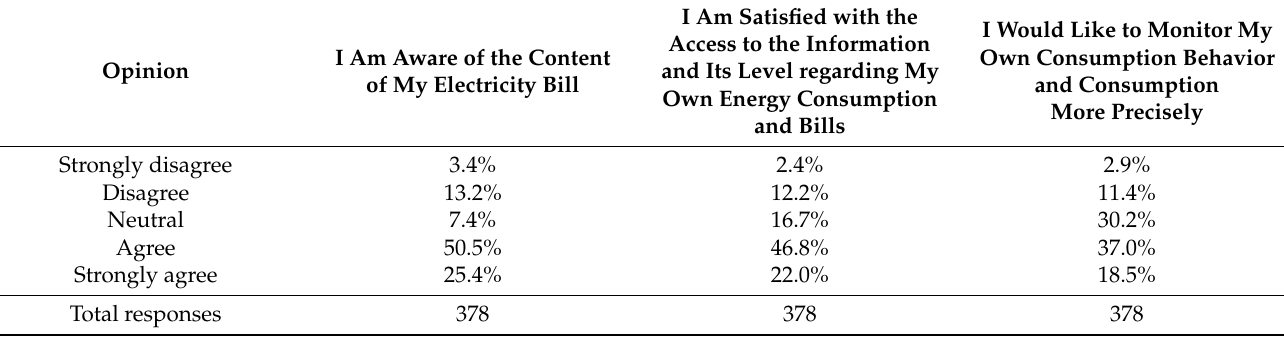
Table A5. The respondents’ opinions on consciousness-related